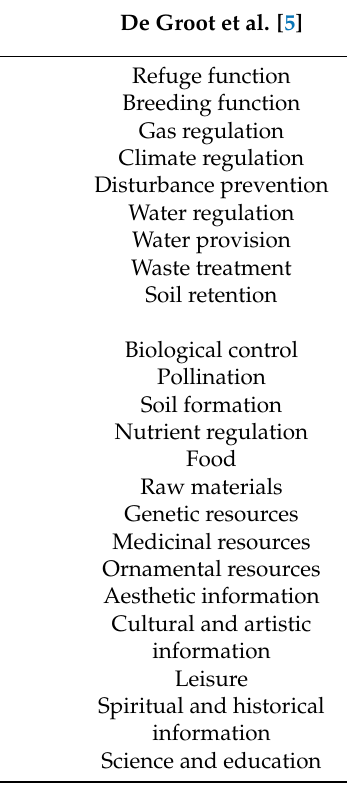
Table 1. Comparative analysis of the different lists of ecosystem services proposed since the term was coined. In the case of the Millennium Ecosystem Assessment, the category to which each service belongs is provided: provisioning (p), regulation (r), cultural (c) and support (s) services. Study of Critical Constanza et al. [3] De Groot et al. [5] Environmental Problems [1] Refuge Refuge function Breeding function Atmosphere